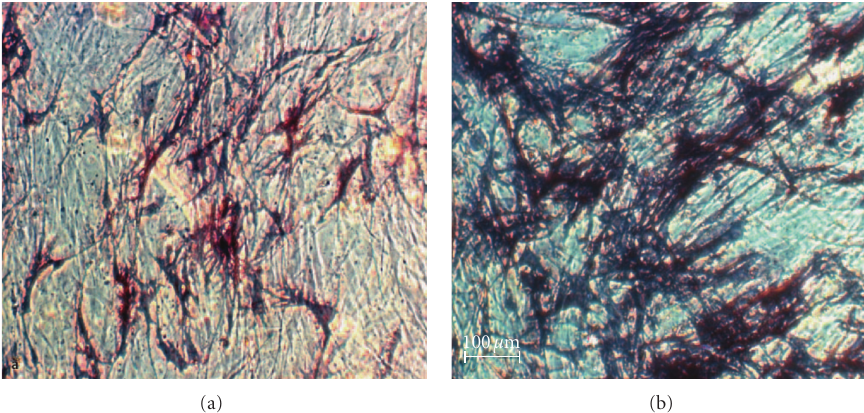
Figure 1: This photomicrograph (at 400 power magnification) shows human osteoblasts in culture after 28 days stained to show Alkaline Phosphatase production as dark blue. (a) Estradiol at a physiological concentration. (b) Estradiol alone for 7 days combined with Progesterone for 21 days. Note the lack of alkaline phosphatase staining in (a) exposed to estrogen alone, and the marked ALP staining indicating osteoblast di ff erentiation/maturation induced by the addition of progesterone, (b) This figure is reprinted from [20] with permission from authors (Schmidmayr M and Seifert-Klauss V). Publisher permission provided.